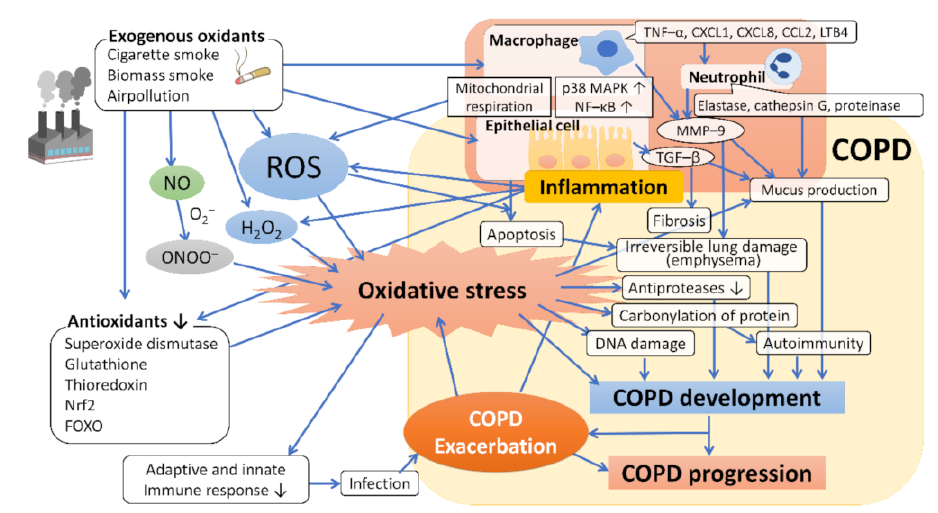
Figure 1. Oxidative stress and the mechanism underlying the development and progression of COPD. Exogenous oxidants such as cigarette smoke contain ROS, which act to promote oxidative stress and induce inflammation of macrophages and bronchoalveolar epithelial cells by activating transcription factors such as NF– κ B, which leads to further ROS generation (endogenous ROS). The host’s antioxidants, such as superoxide dismutase, glutathione, thioredoxin, and Nrf2, are attenuated by the coordination of exogenous oxidants and various mediators of the associated inflammation, resulting in enhanced oxidative stress. Oxidative stress regulates the expression of the mucin gene to increase mucin secretion, inducing DNA damage and causing autoimmunity through carbonylation of proteins, and reduces antiprotease activity, leading to the development and progression of emphysema and fibrosis. Abbreviations: ROS, reactive oxygen species; H 2 O 2 , hydrogen peroxide; NO, nitric oxide; O 2– , superoxide anion; ONOO – , peroxynitrite; NF– κ B,